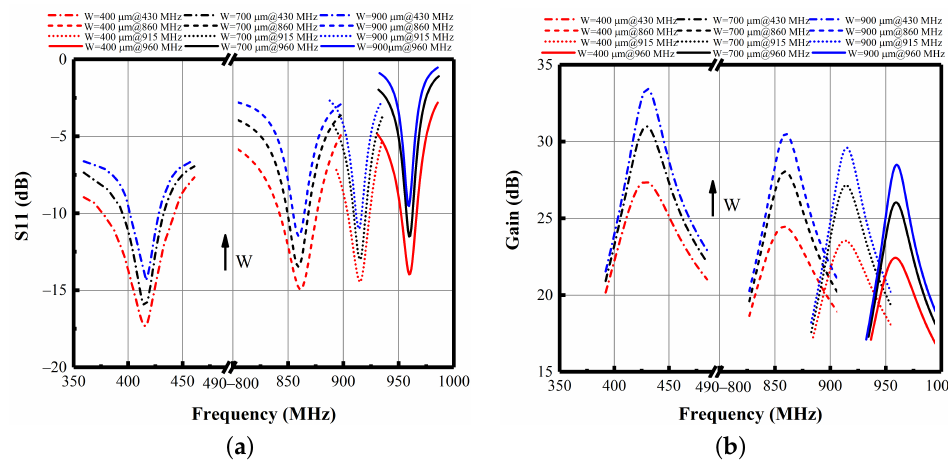
Figure 5. Simulated ( a ) S11 and ( b ) Gain of the LNA for four ISM bands of 430 MHz, 860 MHz, 915 MHz, and 960